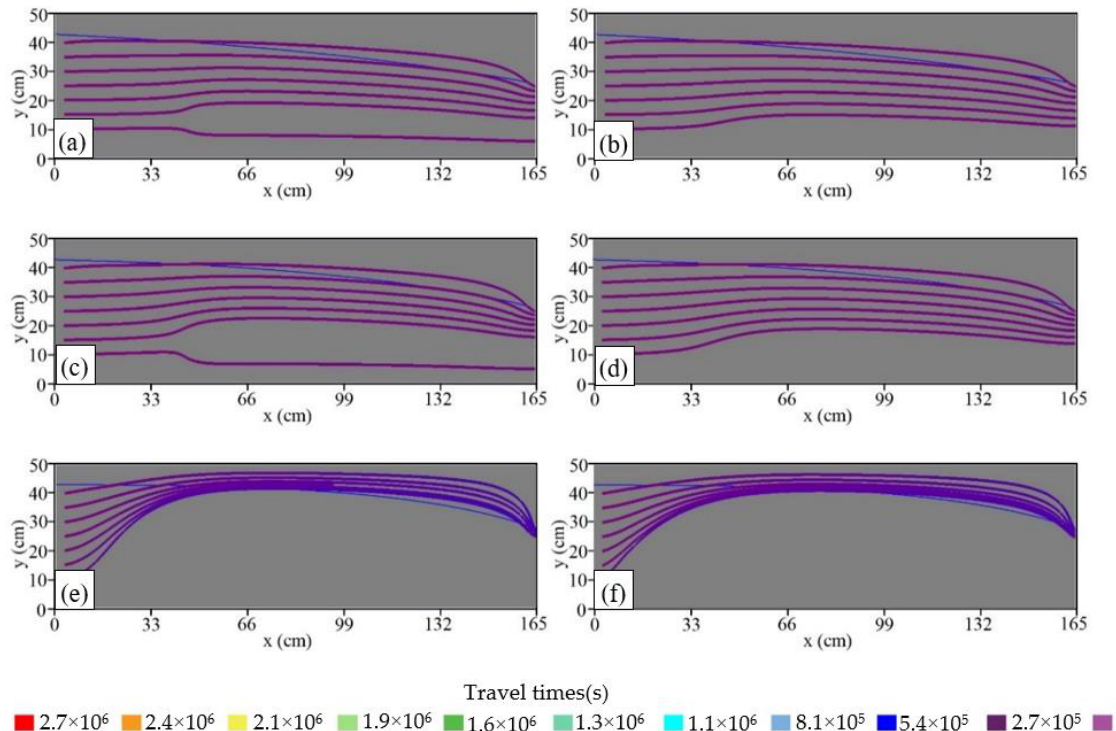
Figure 15. Ambient groundwater flow paths associated with travel time produced by artificial recharge and different length-decay exponents. The left panel of figures were produced by injection well IW2 and the right panel of figures were produced by injection well IW1. The length-decay exponents in ( a ) and ( b ) were set to 0.005 m −1 . The length-decay exponents in ( c ) and ( d ) were set to 0.01 m −1 . The length-decay exponents in ( e ) and ( f ) were set to 0.02 m −1 . The blue lines in the figures represent the water table.